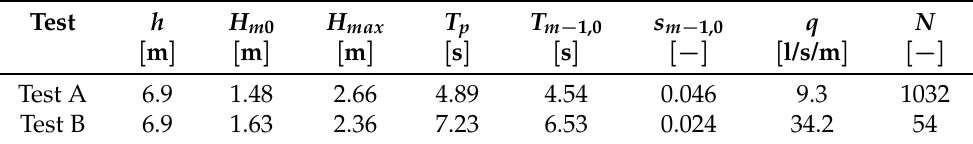
Table 1. The wave characteristics during the two tests with the water depth h , significant wave steepness s m − 1,0 , and number of waves N .